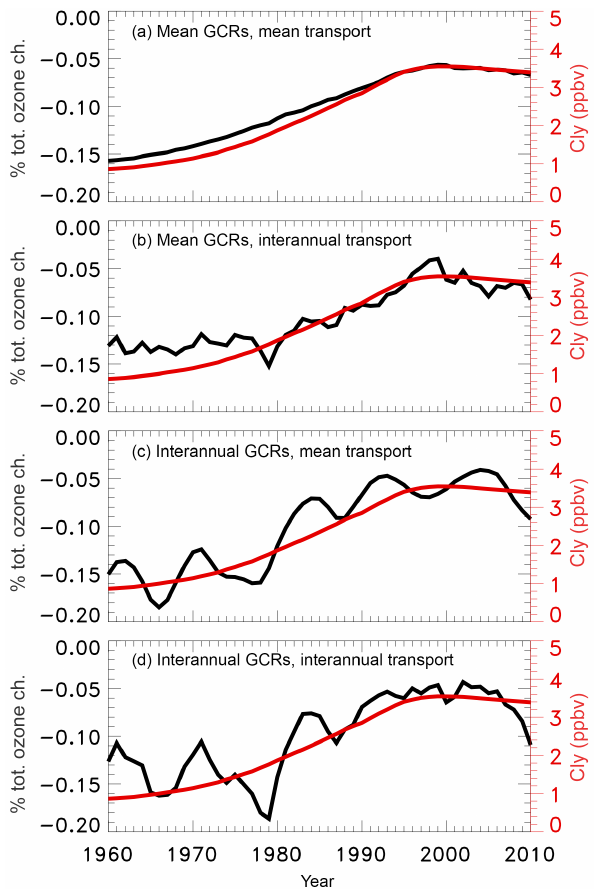
Figure 11. GSFC 2-D model GCR-computed AAGTO impacts (black lines) over the 1960–2010 time period. The Cl y lev- els are also shown (red lines). The GSFC 2-D model com- parisons include (a) mean GCRs, mean transport (simulation A1_GCR_GSFC compared to A_Base_GSFC ); (b) mean GCRs, interannual transport (simulation B1_GCR_GSFC compared to B_Base_GSFC ); (c) interannual GCRs, mean transport (simulation A2_GCR_GSFC compared to A_Base_GSFC ); and (d) interannual GCRs, interannual transport (simulation B2_GCR_GSFC compared to B_Base_GSFC ).